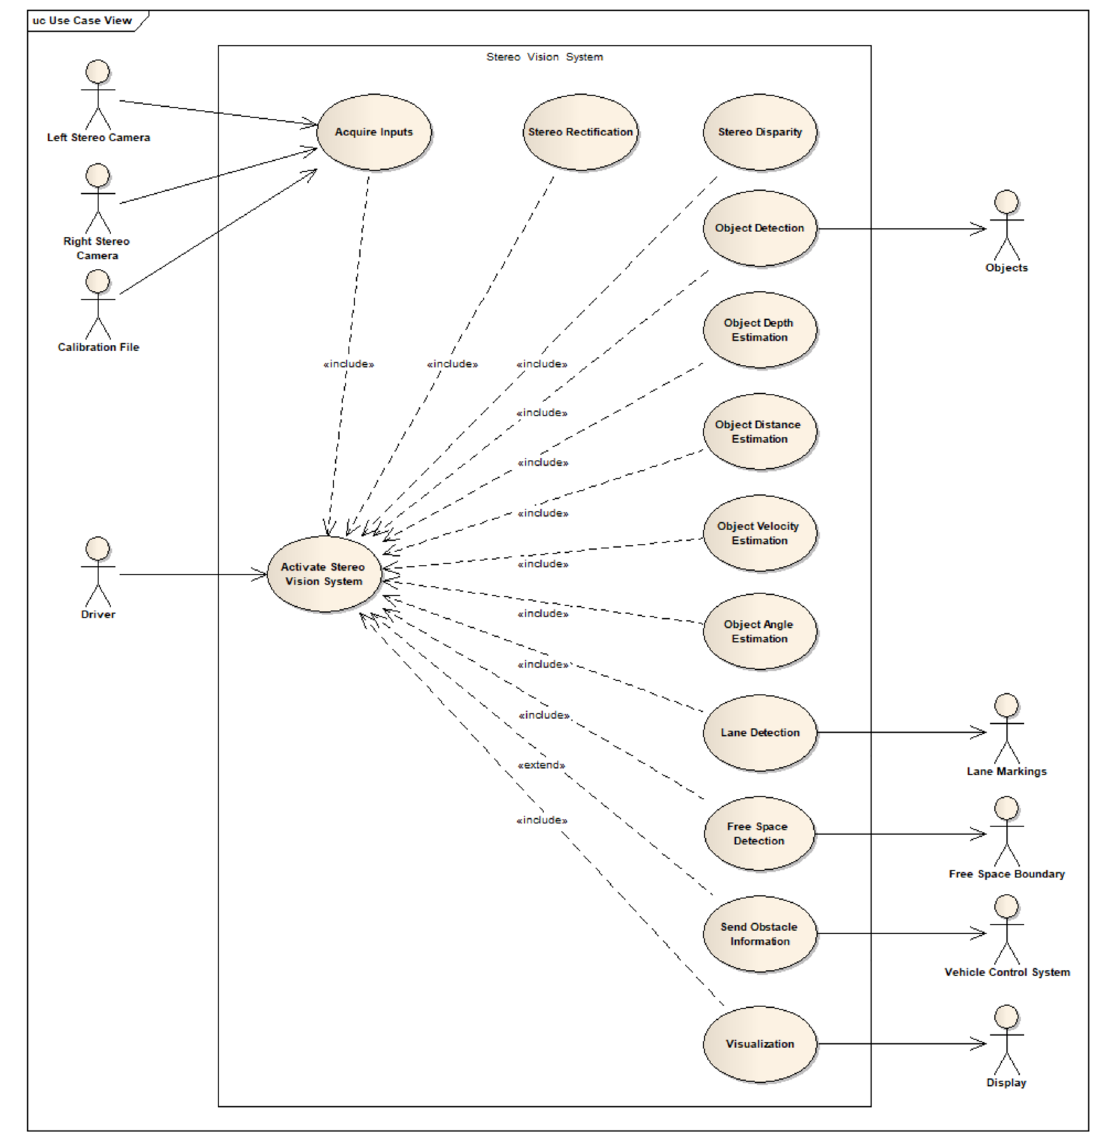
Fig. 7 Use case diagram of the stereo vision